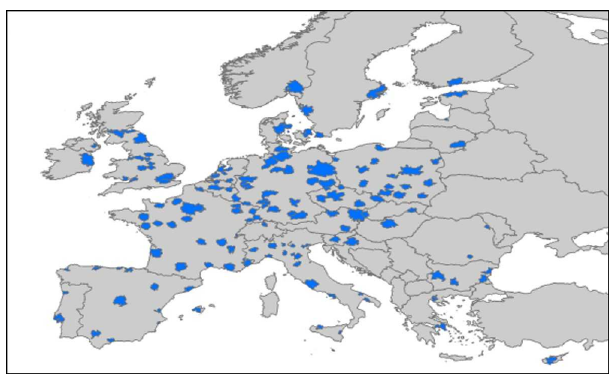
Figure 3. Map of the functional urban areas (FUA) considered for the emission